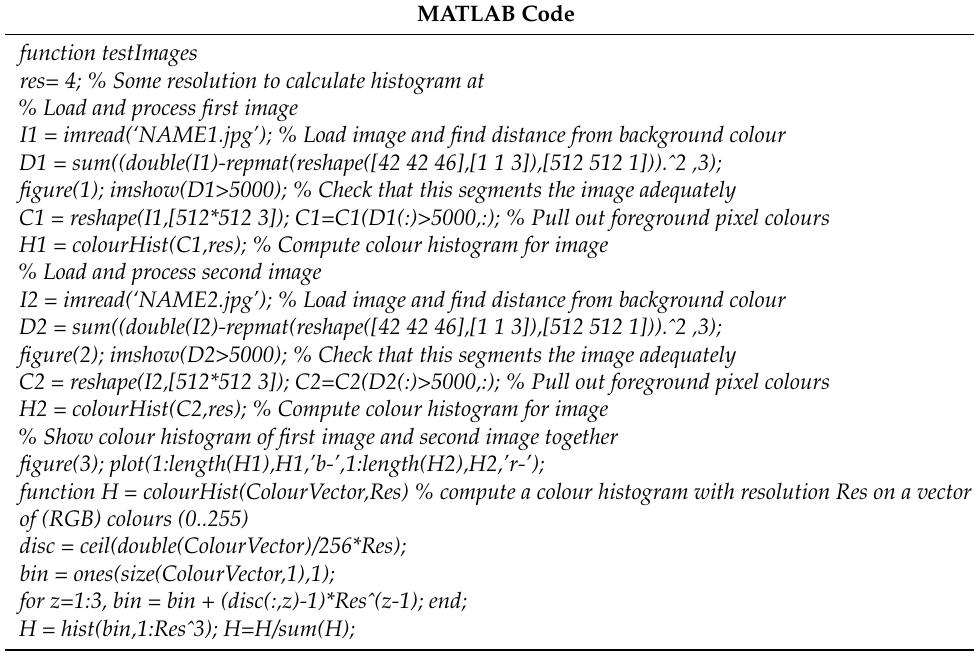
Table 2. Developed MATLAB code used for colour